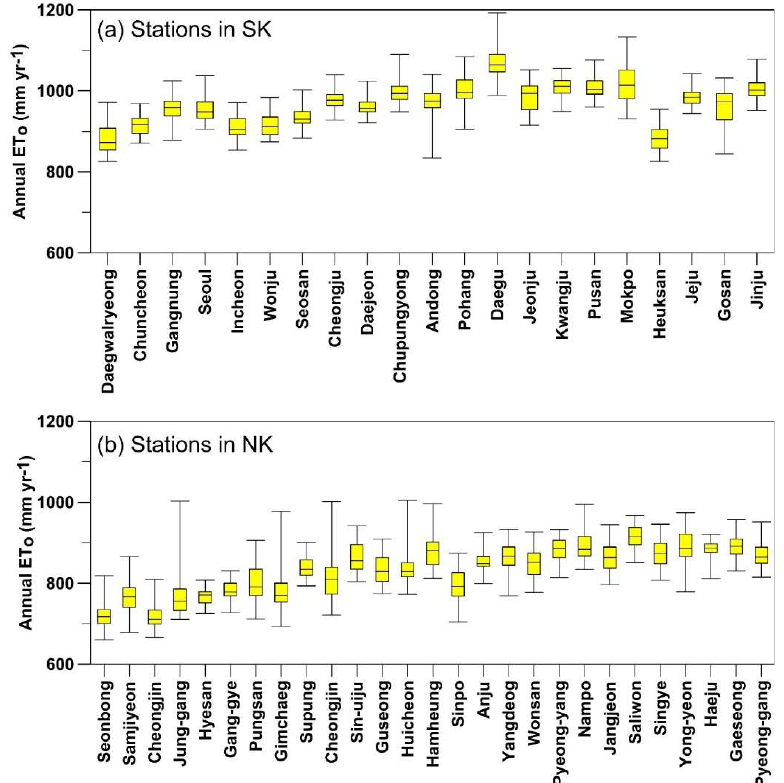
Figure 4. Box-and-whisker plots of the variability of annual ET (cid:2925) for stations in ( a ) North Korea